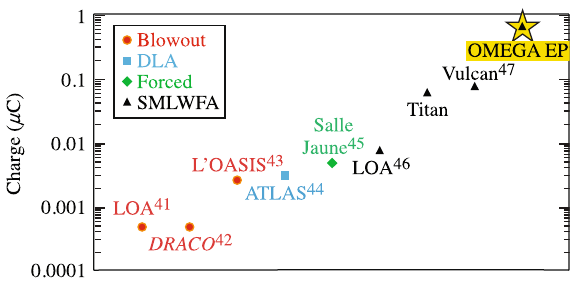
Figure 1. Plot of the maximum charge of the electron beams produced by laser-plasma accelerators at different facilities 41– 47 . The yellow star is the result reported in this work.